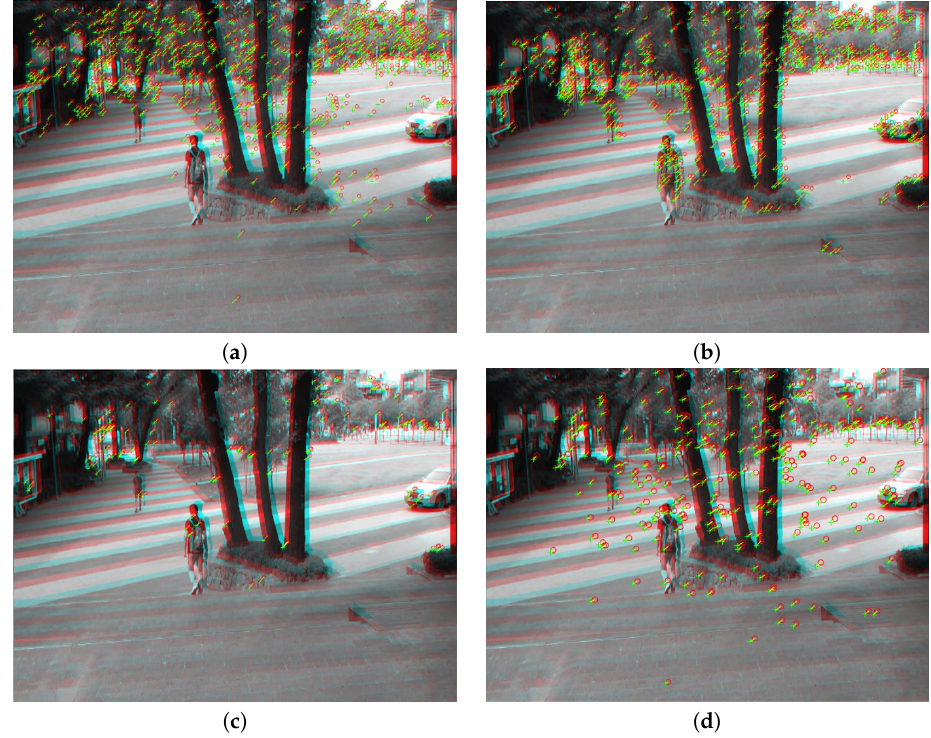
Figure 4. Experimental results of feature matching using: ( a ) SIFT, ( b ) SURF, ( c ) FAST and BRIEF, and ( d ) the proposed particle keypoint detection